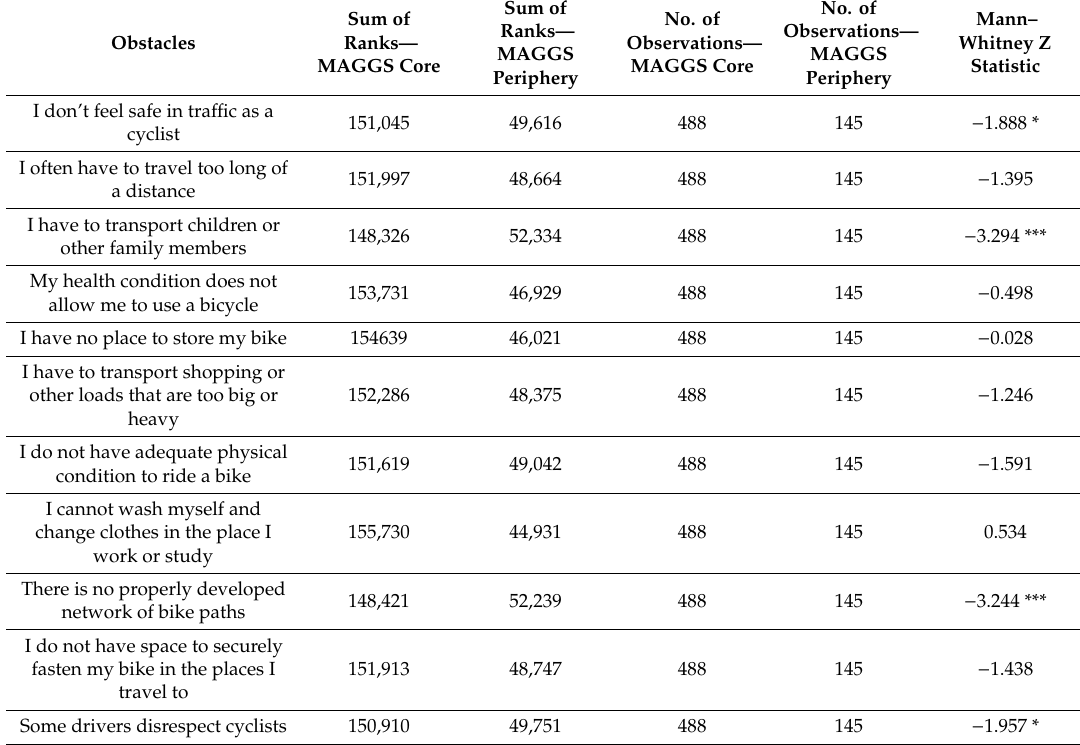
Table 4. Obstacles influencing the decision to ride a conventional bike. Di ff erences in the responses of inhabitants living in the core and in the periphery of the